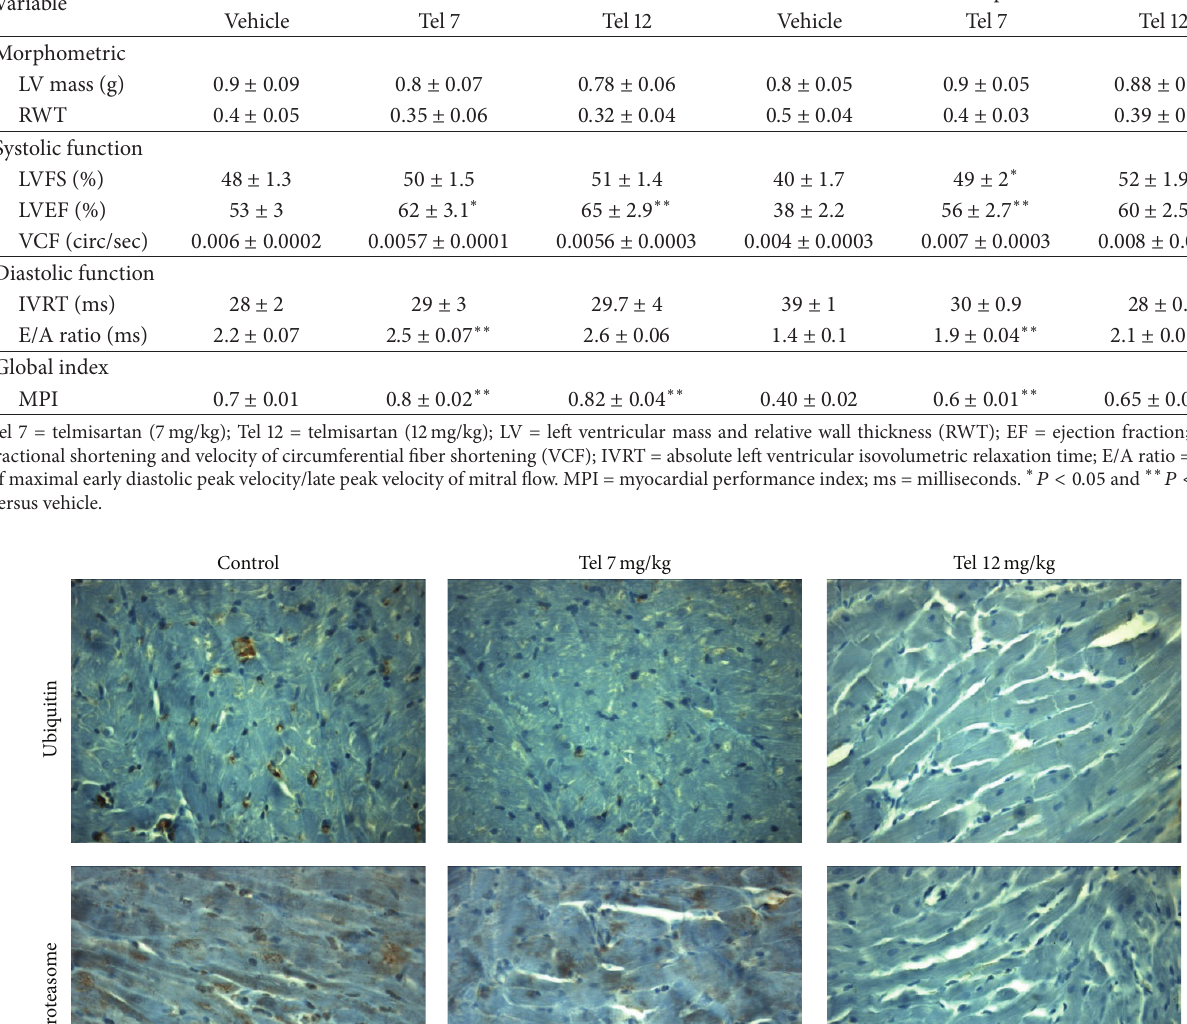
Table 2: Cardiac parameters evaluated by echocardiography in ZDF rats before and after acute myocardial infarct. Variable